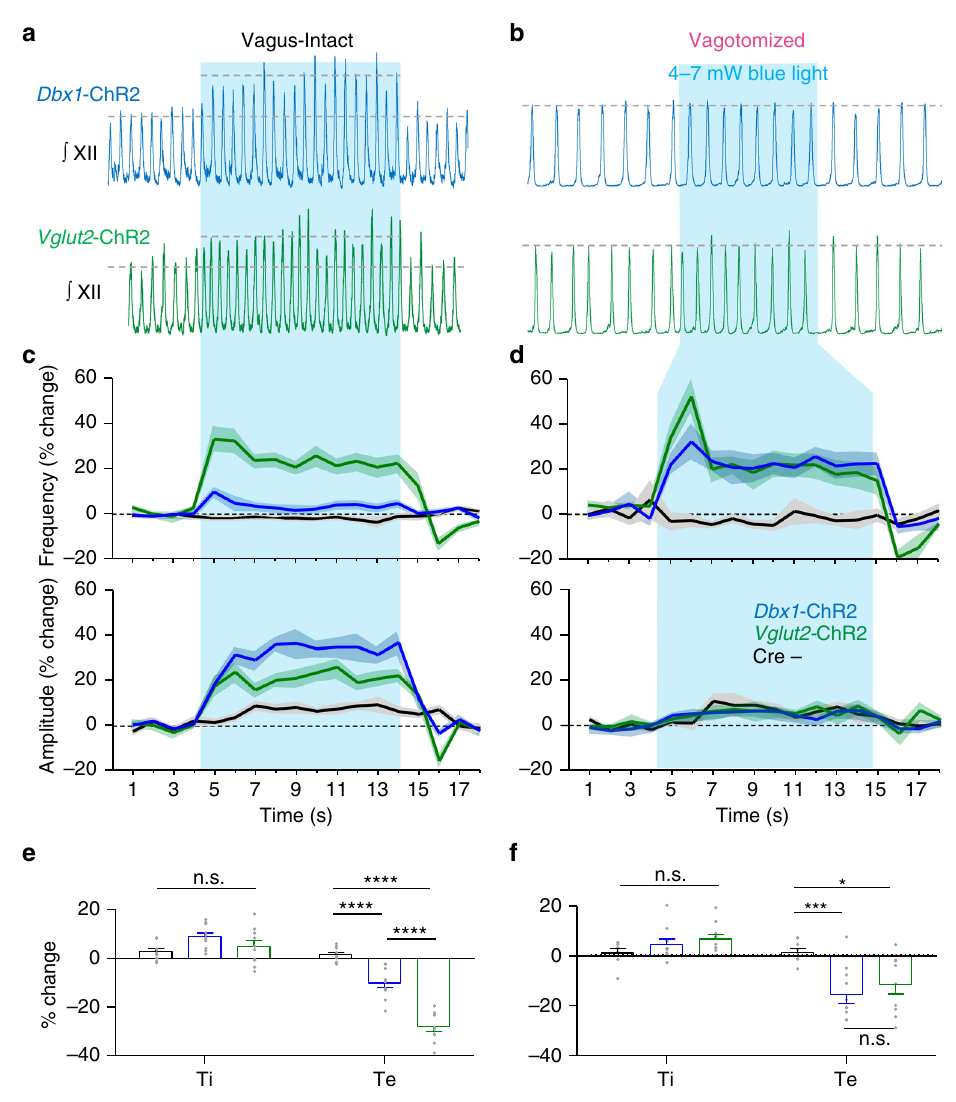
Fig. 7 Excitatory preBötC neurons have a limited ability to generate rapid breathing in vivo. a , b Representative hypoglossal (XII) nerve activity during a continuous 10 s stimulation of the preBötC in Dbx1 -ChR2, Vglut2 -ChR2, and Cre- control mice with the vagus intact ( a ) and following vagotomy ( b ). c , d Average XII nerve burst frequency and amplitude (1 s bins) during continuous light stimulation with the vagus intact ( c ) (Dbx1, n = 11; Vglut2, n = 10; Cre − , n = 10) and following vagotomy ( d ) (Dbx1, n = 10; Vglut2, n = 10; Cre − , n = 8; means± s.e.m.). e , f Average changes in inspiratory and expiratory time (Ti and Te, respectively) during continuous stimulation in vagus-intact ( e ) and vagotomized ( f ) mice demonstrating that changes in breathing frequency are primarily the result of reduced Te (mean ± s.e.m.; two-way ANOVA and Bonferonni ’ s multiple comparisons test; ** p < 0.01, *** p < 0.001, **** p <